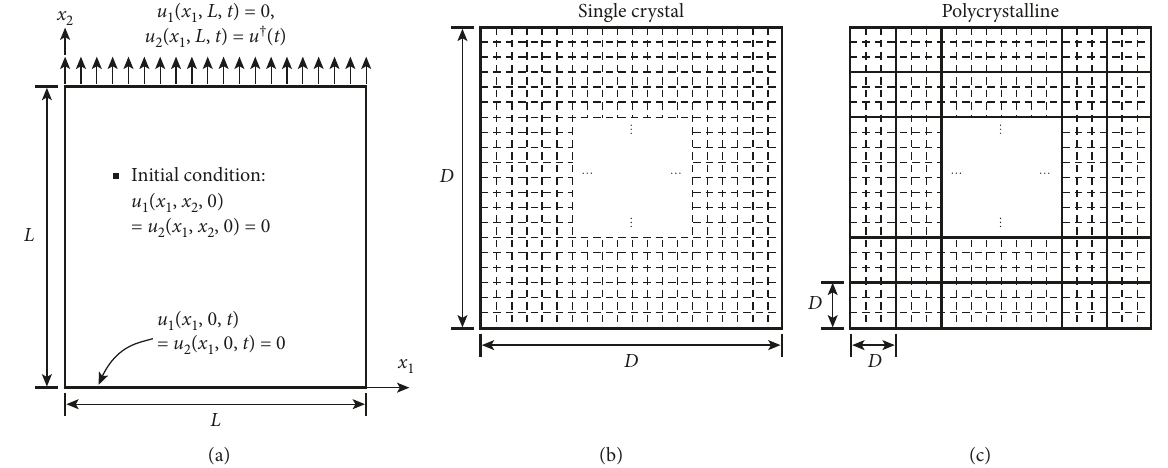
Figure 2: Schematic illustration of uniaxial strain problem with single crystal and polycrystalline materials. D is the (average) grain size. Dotted lines and bold lines in single crystal and polycrystalline materials represent finite element mesh and grain boundary, respectively.